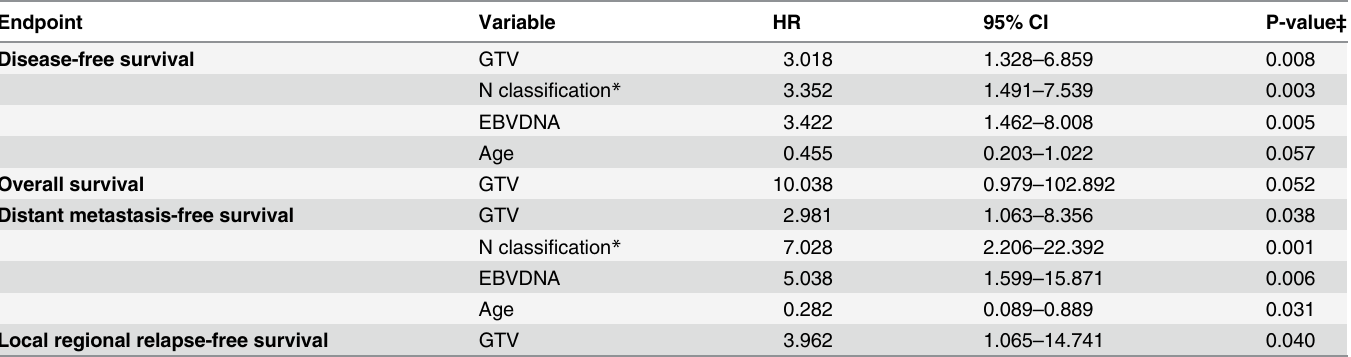
Table 5. Multivariate analysis of the impact of all variables on survival. Endpoint Disease-free survival